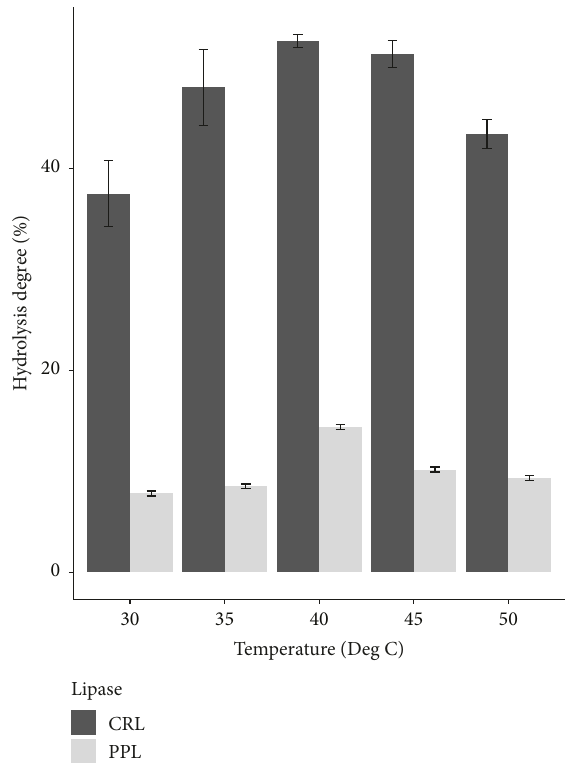
Figure 5: Hydrolysis time of two lipase